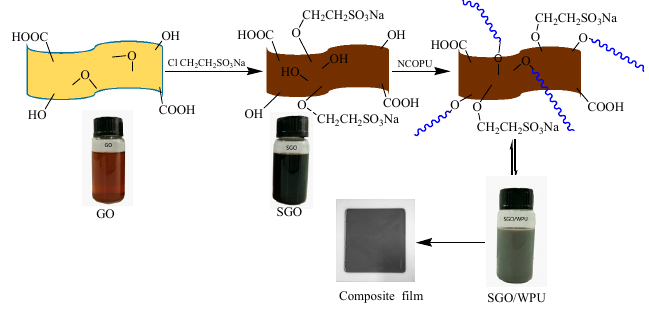
Figure 1. Schematic diagram about the synthesis route for SGO/WPU.